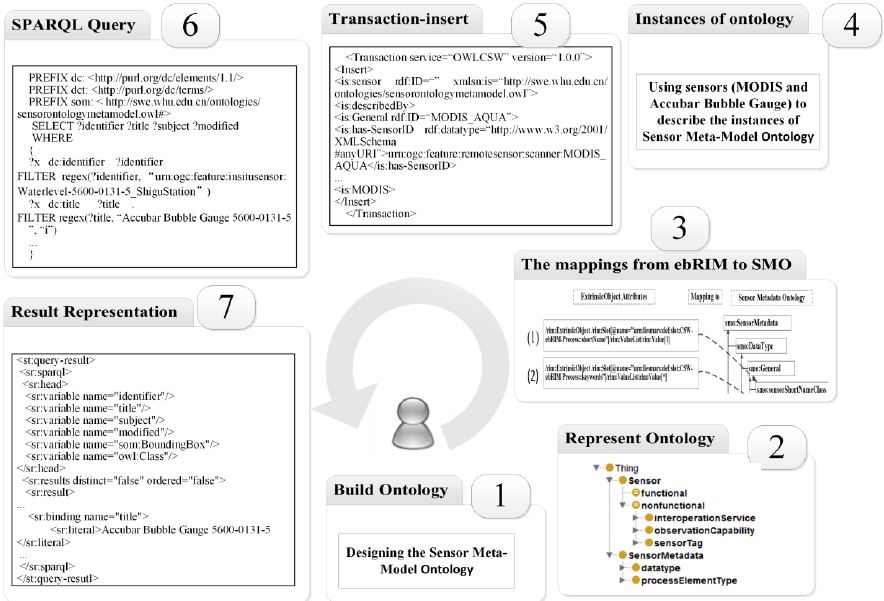
Figure 1. The flow of the sensor semantic registry service.